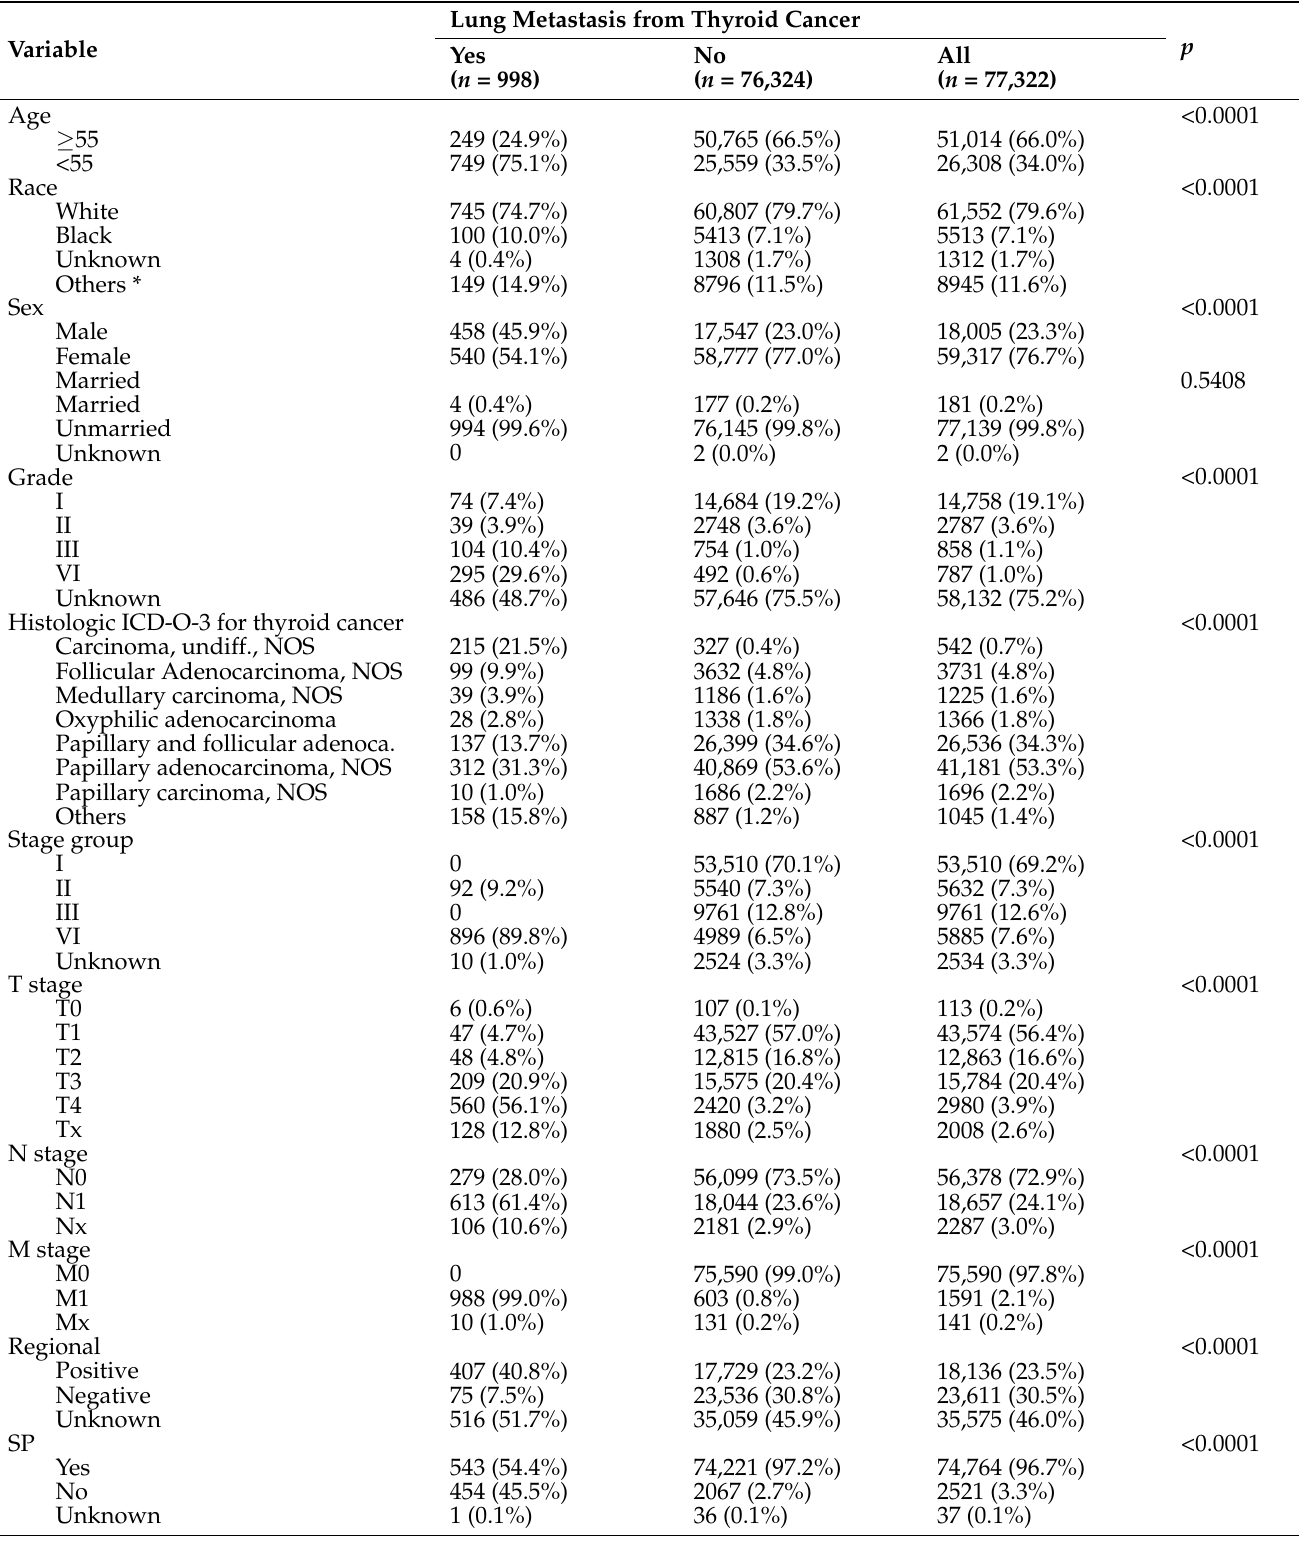
Table 1. Clinical features of TC patients with or without lung metastasis from thyroid cancer.